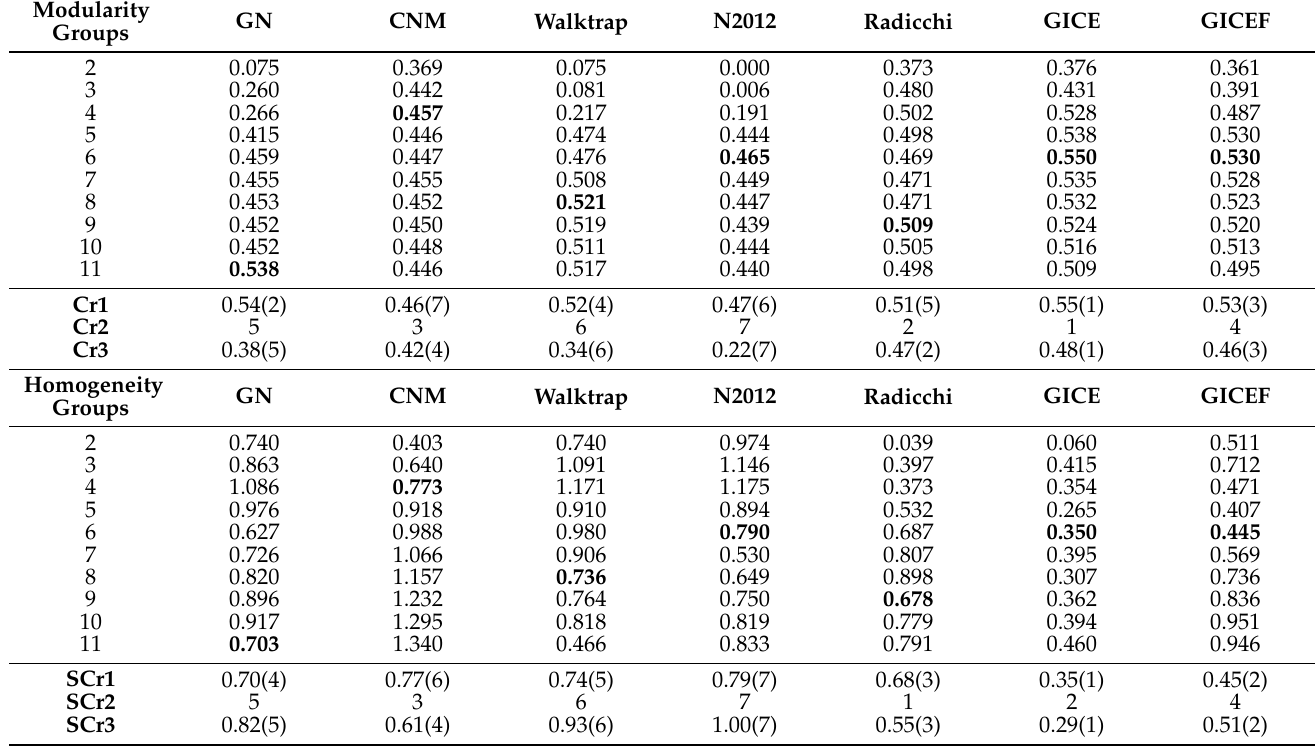
Table 4. Modularity and Homogeneity for partitions with k groups ( k = 2, . . . ,11) obtained using the GN, CNM, Walktrap, N2012, our GICE and its fast version (GICEF) for Les miserables network. The criteria values are shown in